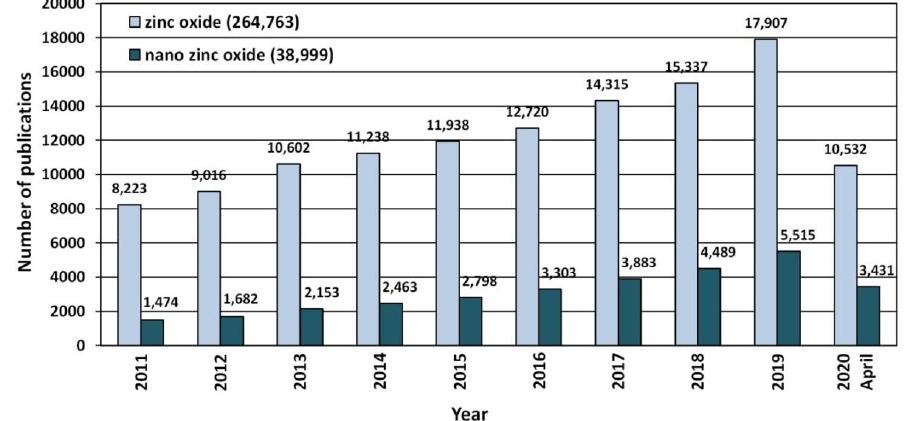
Figure 3. The number of scientific publications referring to the search of “zinc oxide” and “nano zinc